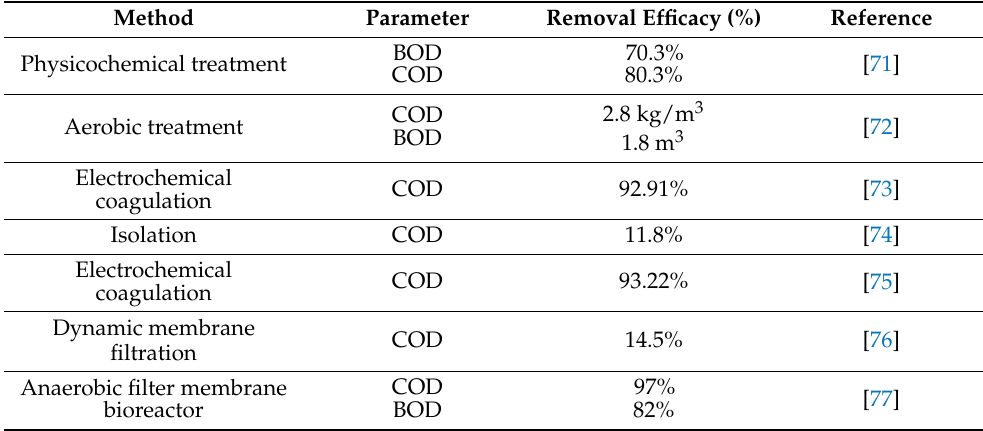
Figure 7. Schematic representation of the meat processing industry. Table 5. Wastewater treatment in meat production industries.